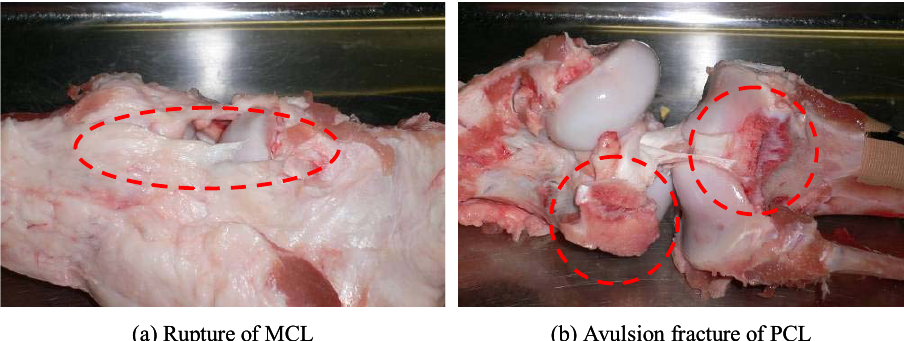
Fig. 5 Injury pattern of knee joint for drop height of 500 mm (test3): (a) completely ruptured MCL and (b) fractured lower insertion of PCL.